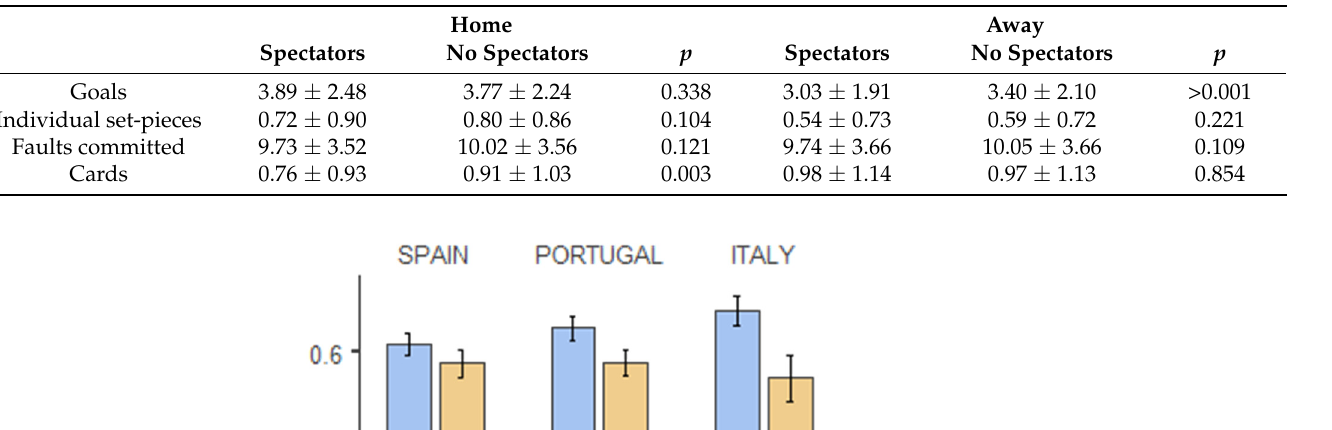
Table 2. Descriptive analysis of match variables according to match location and spectators presence. The data represents events per match for each team and are shown as mean ± SD.